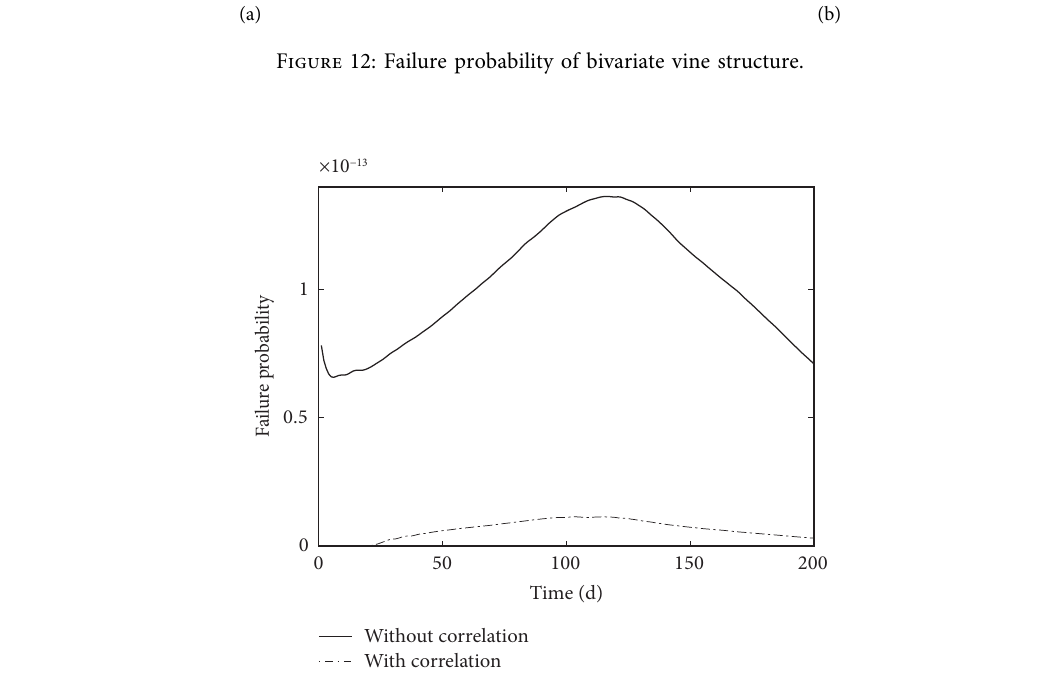
Figure 13: Predicted bridge girder failure